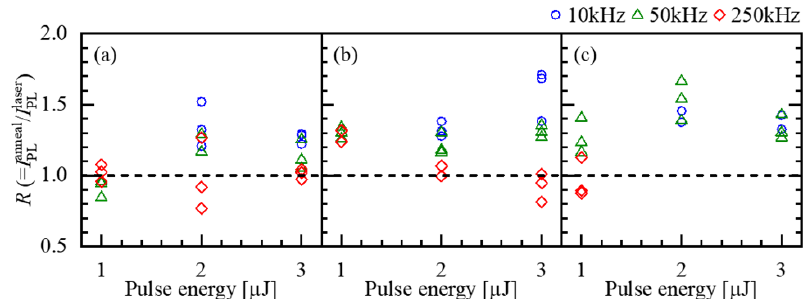
annealing at ( a ) 300 °C, ( b ) 500 °C, ( c ) 700 °C for 30 min. The PL intensity was normalized as the